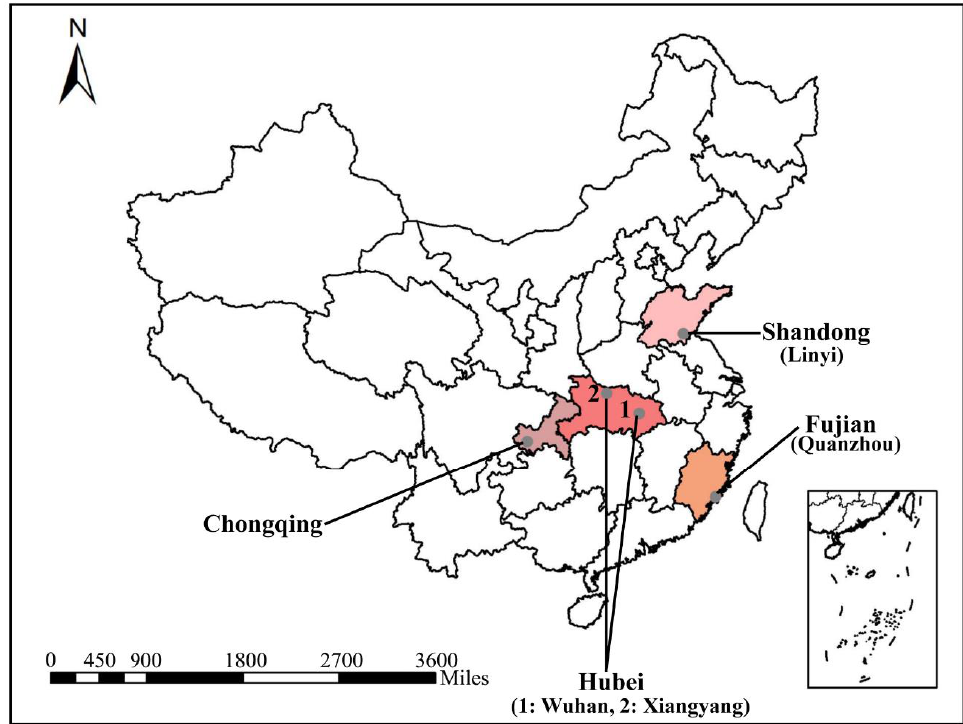
Figure 1. Geographical distribution of sampling sites. Feline blood samples from three provinces (Fujian, Hubei and Shandong) and one municipality (Chongqing) in China.